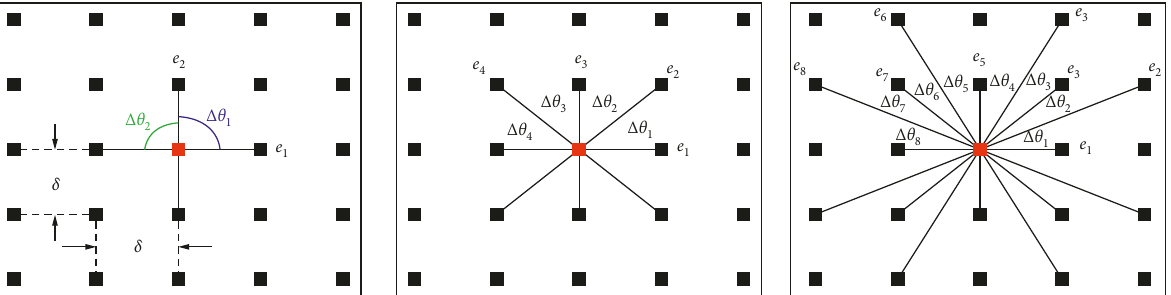
Figure 3: Different neighborhood systems used to estimate the length of active contour. (a) N